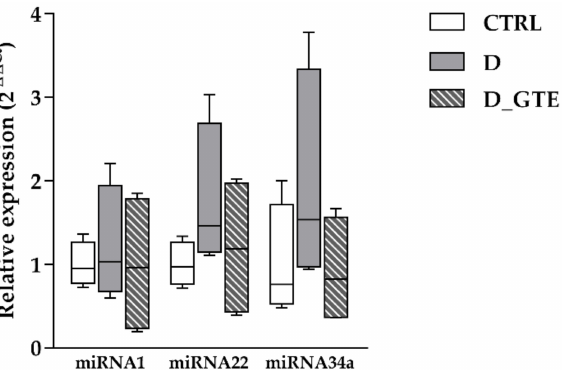
Figure 7. Differences in microRNA expression between the control (CTRL), diabetic (D) and GTE- treated groups (D_GTE), measured through TaqMan MicroRNA Assays for miRNA1 (rno-miR1-3p), miRNA22 (rno-miR22-3p) and miRNA34a (rno-miR34a-5p). Relative miRNA expression levels of the target genes were calculated as fold changes (2 − ∆∆ Ct ). Data are presented as box and whisker plots with bar graphs showing the median value. No statistically significant differences in the expression of the three miRNAs were notified among the three groups (Kruskal–Wallis